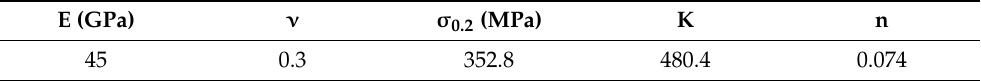
Figure 4. ( a ) Device used in the ECAE test; ( b ) dimensions of the billet used in the ECAE test; ( c ) ECAE device with billets on 120° and 90° channels 8; ( d ) undeformed and deformed billets. The mechanical characterization of the material includes microhardness and tensile tests (see Figure 3). The microhardness test was performed with a Leitz tester (Esselte